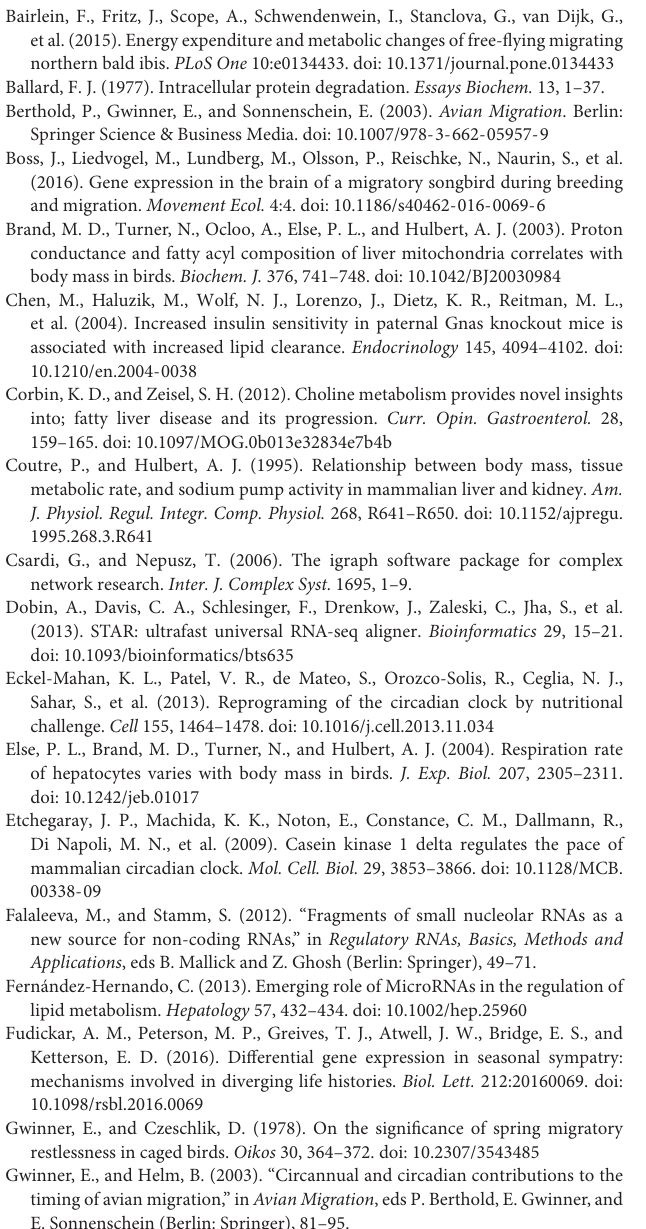
TABLE S3 | List of GO terms in blue and turquoise modules derived from WGCNA analysis. TABLE S4 | List of cycling genes under migratory and non-migratory states. A gene was characterized as cyclic with threshold of adjusted P